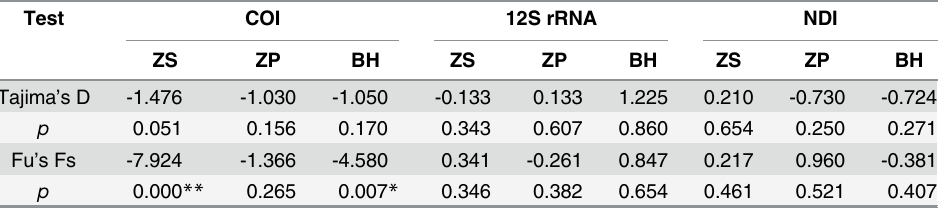
Table 6. Neutrality Test Results for COI, 12S rRNA, and NDI Data Obtained for Macridiscus multifarius